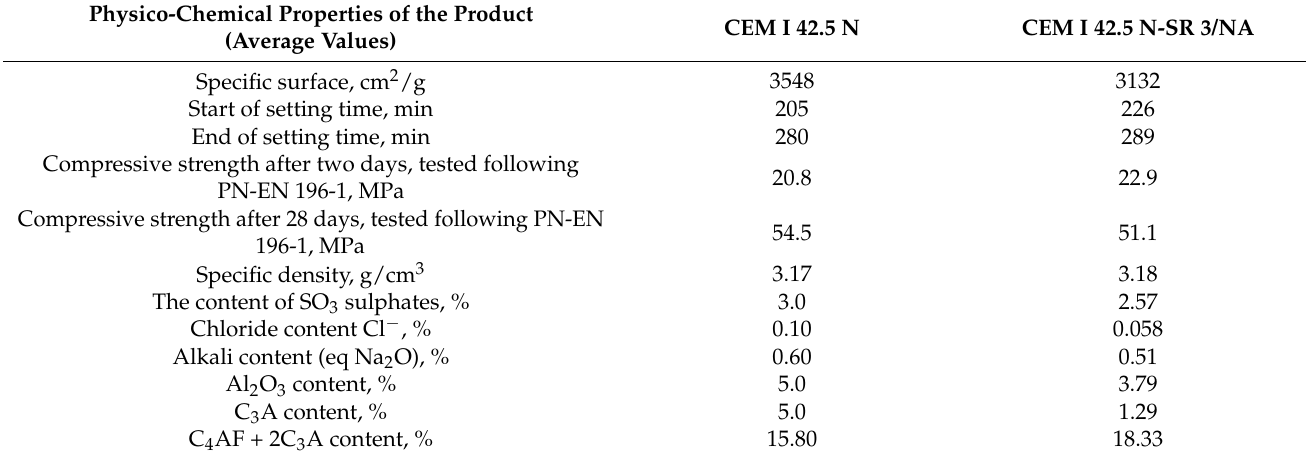
Table 2. Chemical and physical characteristics of